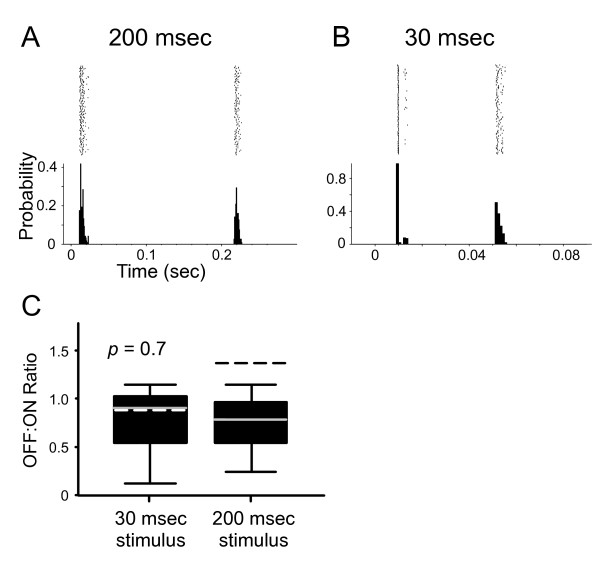
OFF:ON response magnitude ratios for vibrissa-responsive neurons. Examples of responses to 200 msec stimuli (A) and 30 msec stimuli (B) in different neurons. C: Boxplots depicting OFF:ON ratios for 200 and 30 msec stimuli. Decreasing the stimulus duration had little effect on the OFF:ON ratio (P = 0.7).